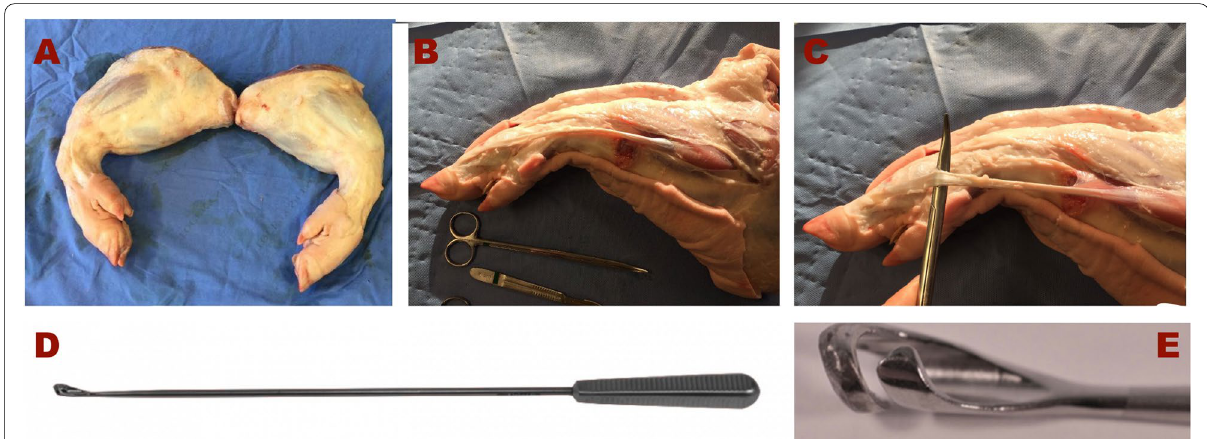
Fig. 3 The three stages of dissection of porcine flexor digitorum superficialis tendon. A shows the right and left limbs before dissection. B and C exhibits the pes anserinus after dissection of the superficial layers of the leg. D shows a standard tendon stripper (Smith & Nephew/Acufex Slotted Tendon Stripper), and E , the details of the open-end of the graft harvester, which is used to release the tendon proximately without